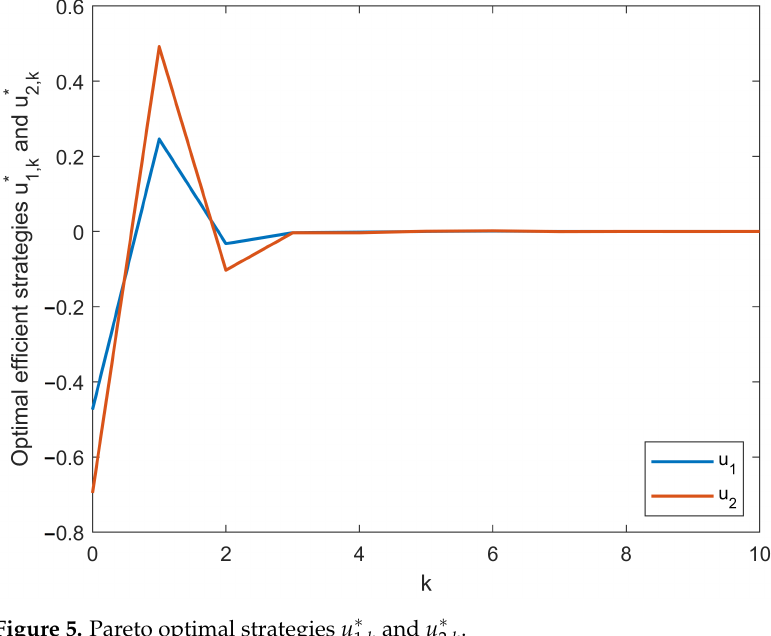
Figure 5. Pareto optimal strategies u ∗